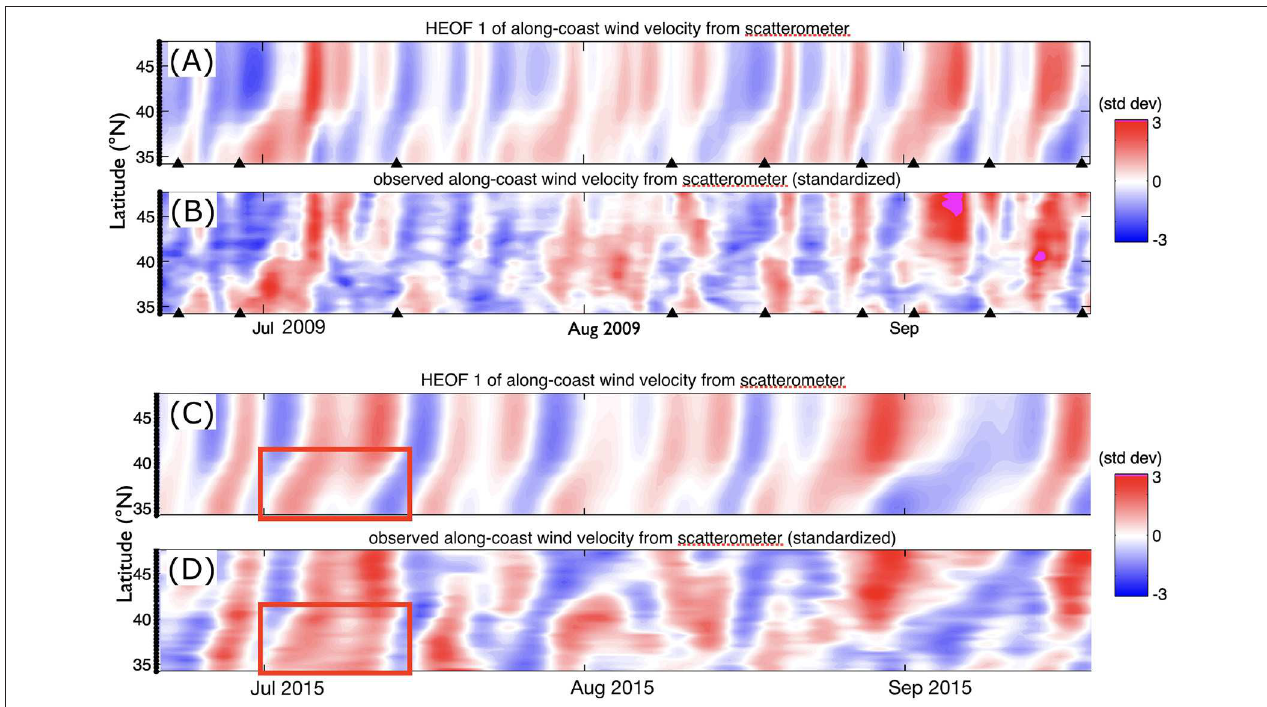
FIGURE 3 | Hovmoller diagrams of along-coast wind velocity and HEOF 1 of wind velocity along the west coast of the United States during summer: (A,B) 2009 from QuikSCAT and (C,D) 2015 from ASCAT. In (B,D) the mean wind velocity was removed and the data scaled by the standard deviation of wind velocity at each site. For (C) , the wind velocities from ASCAT in 2015 were projected onto the HEOF 1 spatial pattern calculated in Fewings (2017). Red boxes indicate 1–14 July 2015, the period preceding the appearance of the split MHW. Red indicates the along-coast wind velocity is below the mean value at that location (i.e., a wind relaxation is occurring). Panels (A,B) are reused from Fewings (2017) with permission; black triangles indicate the onset of wind relaxations at Point Conception, California discussed in that